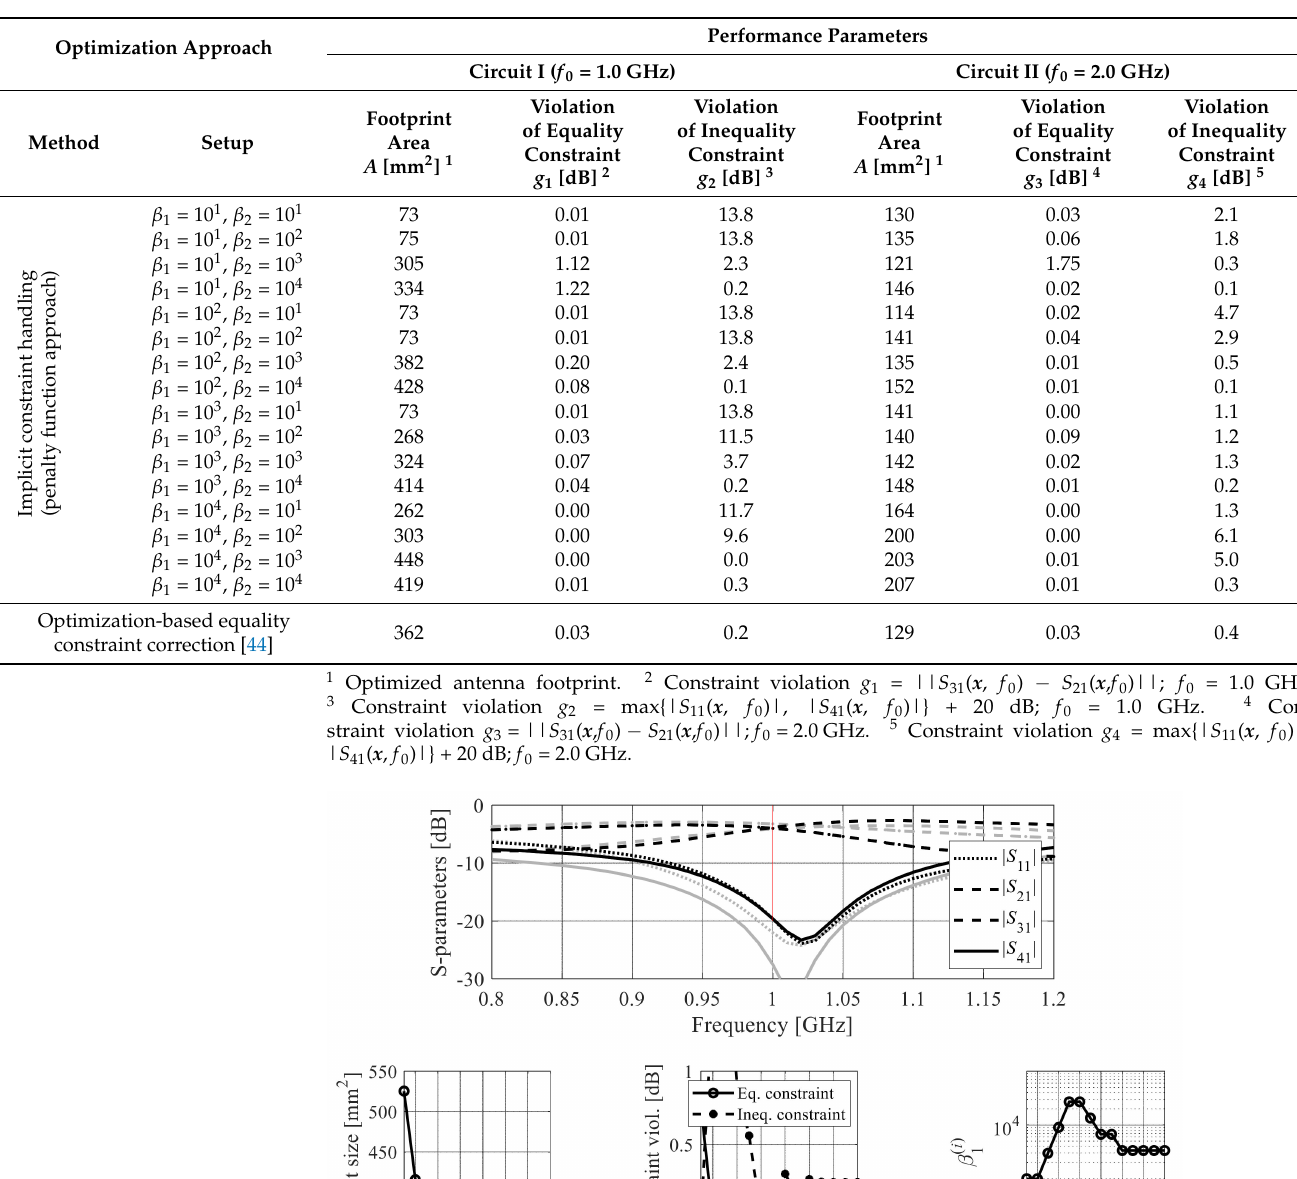
Table 5. Optimization results for Circuit I and Circuit II of Figure 18.